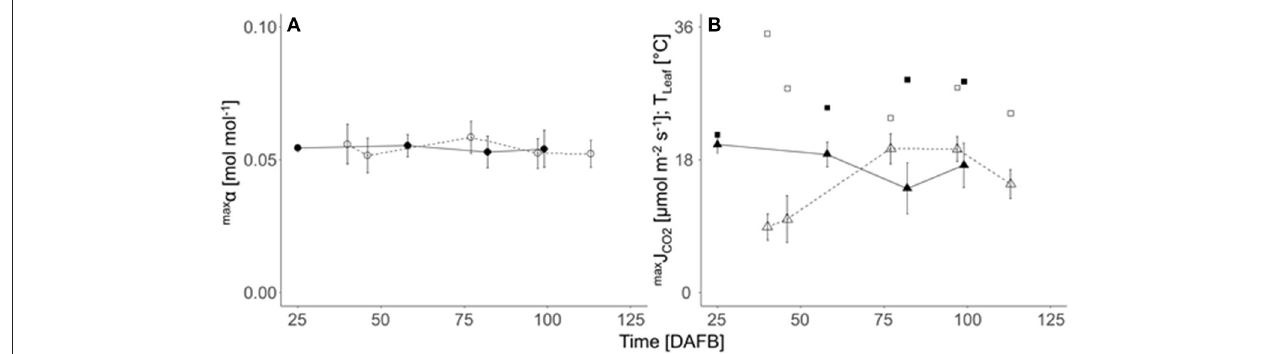
FIGURE 3 | Seasonal course (DAFB) of means ( ± SD ; n = 9) of (A) the maximum quantum efficiency of photosynthesis ( max α , circles), (B) light saturated maximum CO